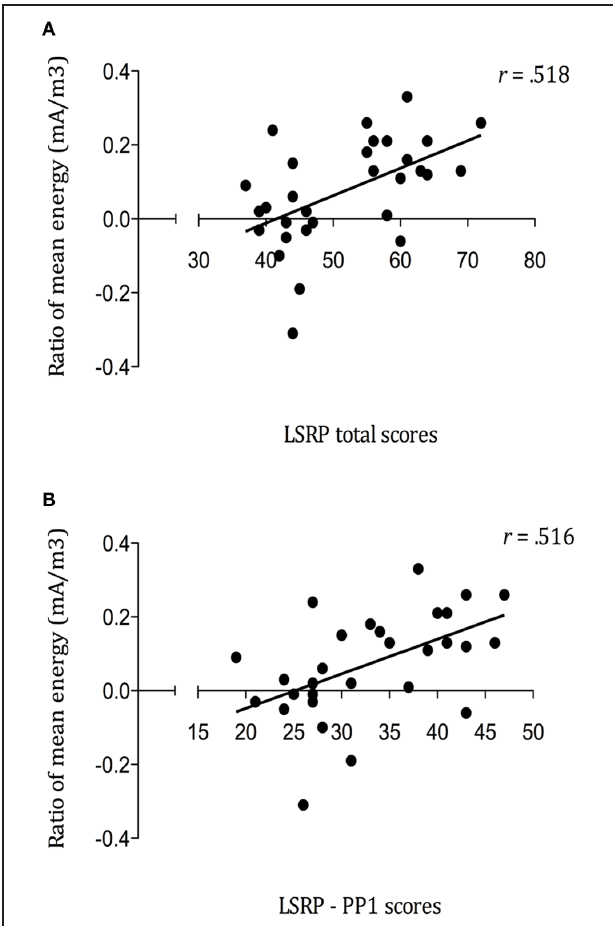
FIGURE 6 | Positive correlations between mean energy (mA/m 3 ) ratios during Pain Gating (1300–1500ms) and (A) self-reported psychopathy total scores ( p = 0 . 003); (B) primary psychopathy (PP1) subscale scores ( p = 0 . 004).